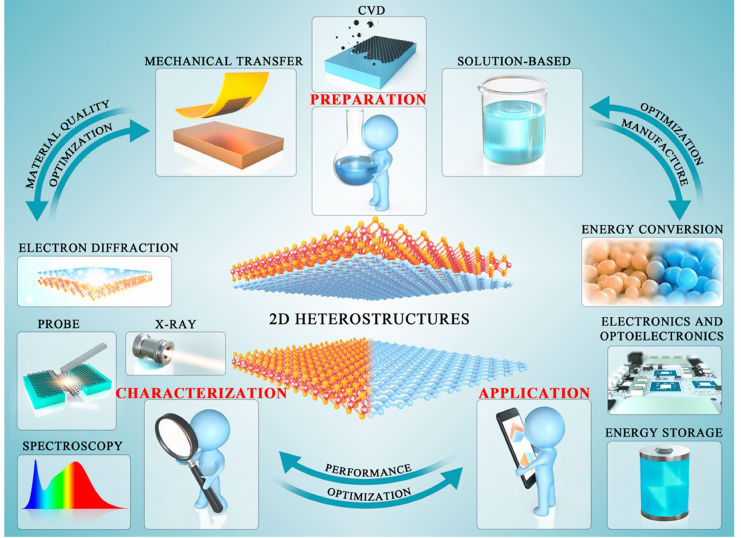
Figure 2. Characteristic approaches executed for research on 2D heterostructures. Adapted with permission from Ref. [40]. Copyright 2022, American Chemical